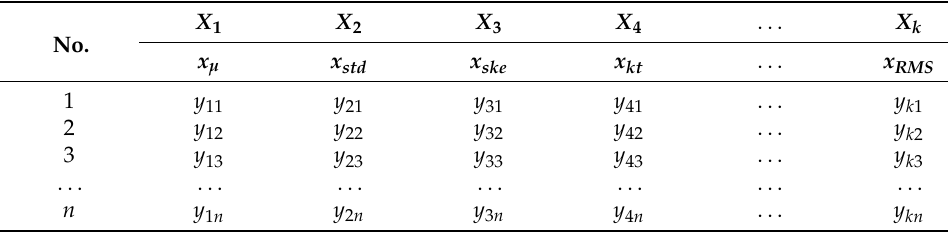
Table 6. Data schema of abnormal group